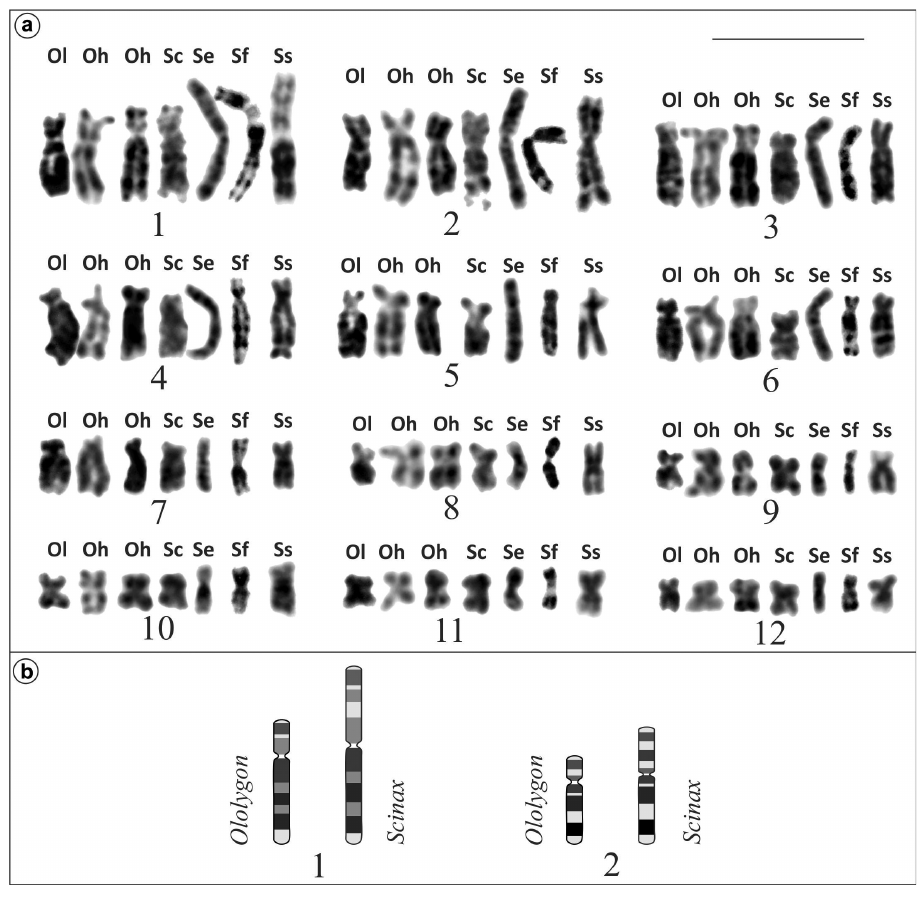
Figure 3. a Comparison of replication bands of the chromosomes of: Ol = O. littoralis ; Oh = O. hiemalis (two distinct metaphases of the same specimen); Sc = S. crospedospilus ; Se = S. eurydice ; Sf = S. fuscovarius ; Ss = S. similis . b Ideogram of chromosomes 1 and 2 of Ololygon and Scinax evidencing loss of segment in the short arms of both chromosomes in Ololygon . Bar = 10